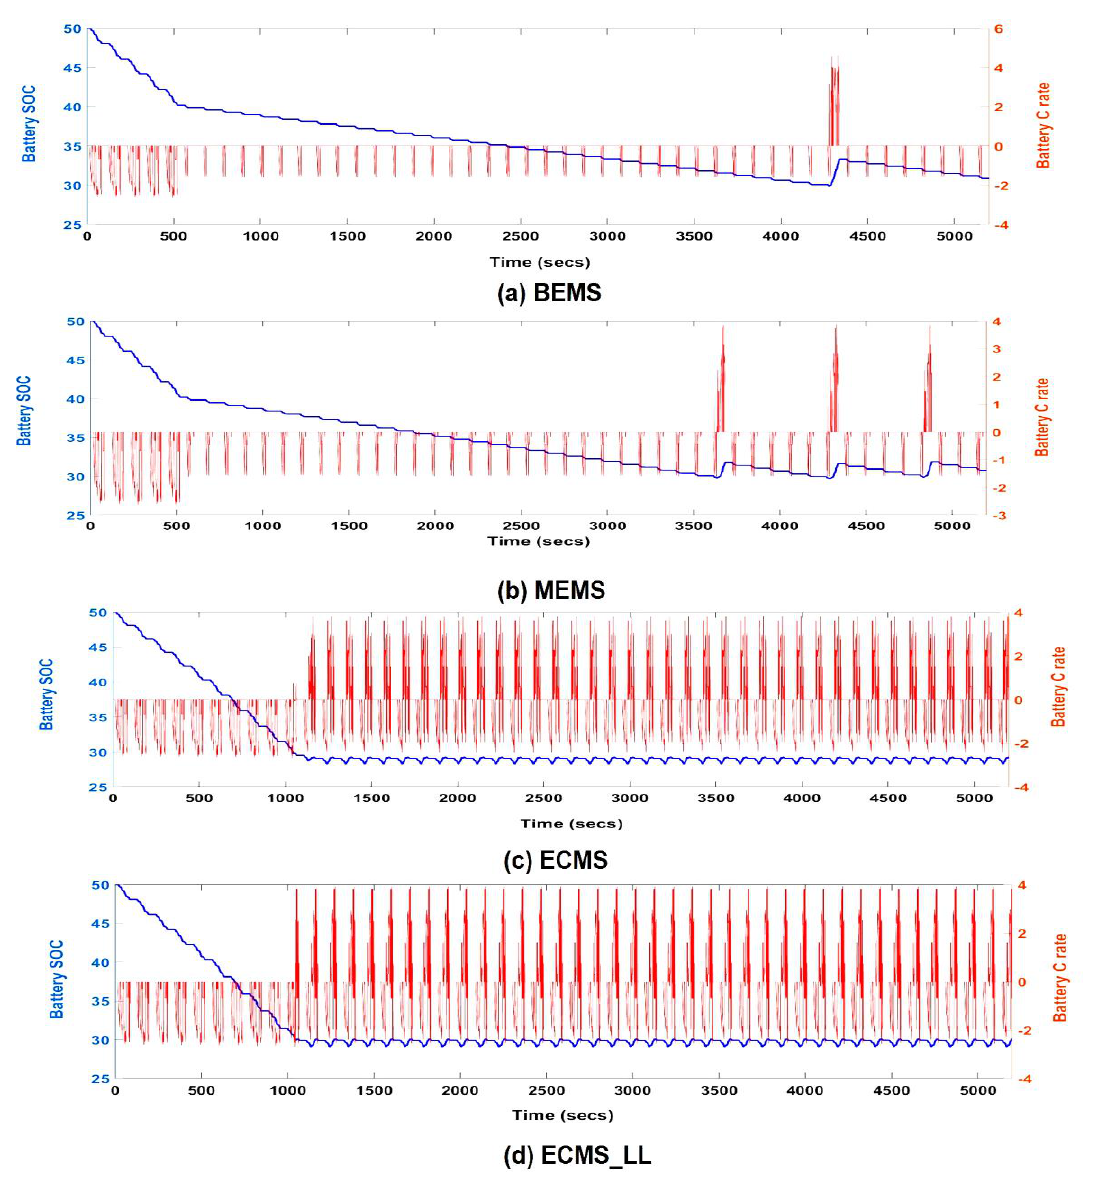
Figure 12. Battery SOC and charge C rate for Veh 1 configuration for different controllers tested for IDC test cycle: ( a ) BEMS, ( b ) MEMS, ( c ) ECMS and ( d ) ECMS_LL.